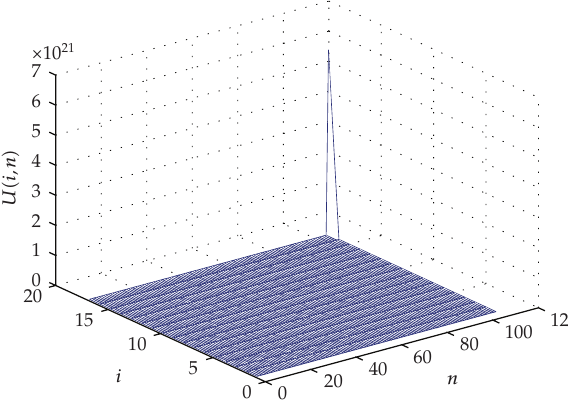
Figure 3: Evolution of the discrete solution, q (cid:2) 3, p (cid:2) 2 (cid:3) explicit scheme (cid:4) .